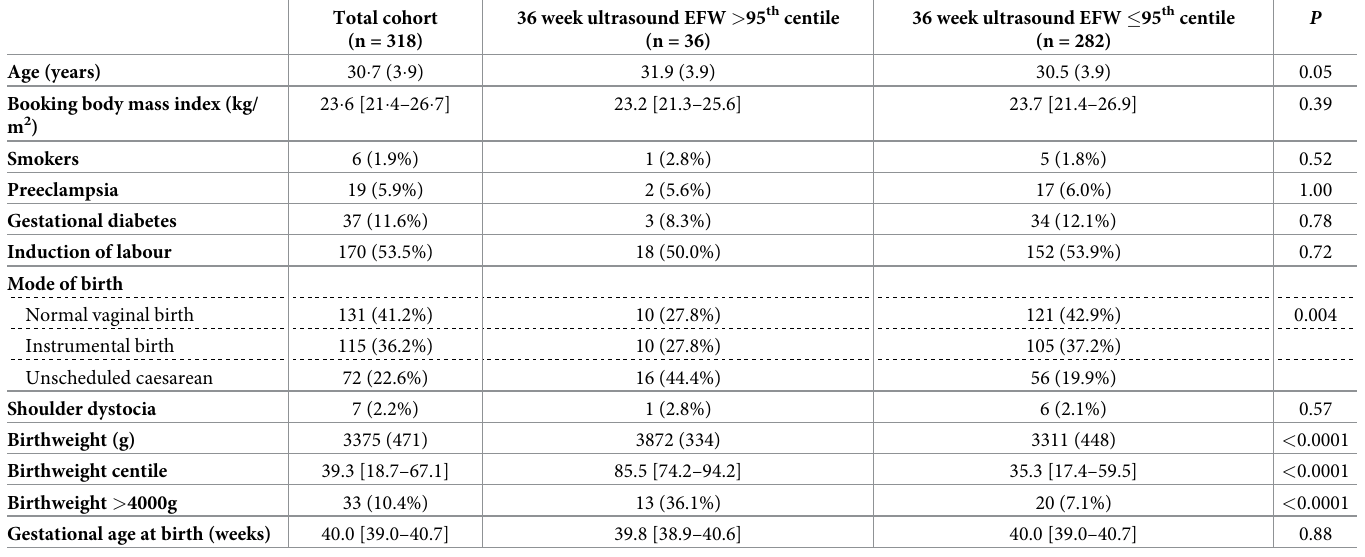
Table 3. Maternal characteristics and delivery outcomes for cohort of participants planned for vaginal delivery, and comparison of EFW > 95 th centile group to EFW � 95 th centile group at 36-week ultrasound.